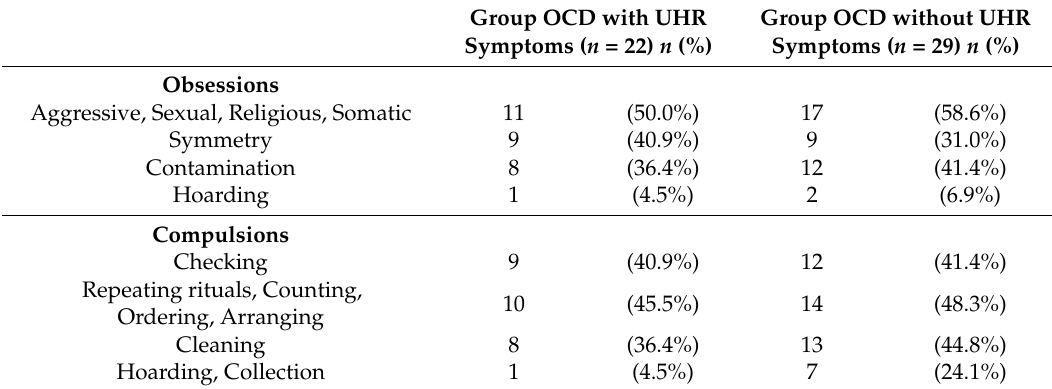
Table 2. Frequency and percentage of obsessions and compulsions based on Four-Factor Model [16].